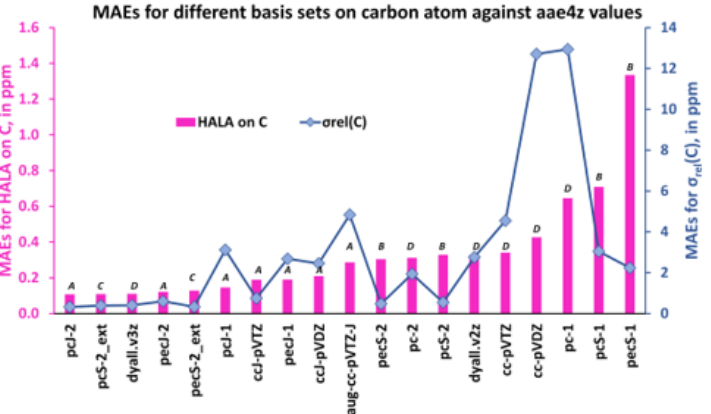
Figure 13. The MAEs for the HALA effect on the carbon shielding constants and that of the carbon shielding constants of molecules 1 – 11 were calculated with different basis sets on light atoms against the values obtained with the dyall.aae4z basis set on all atoms.